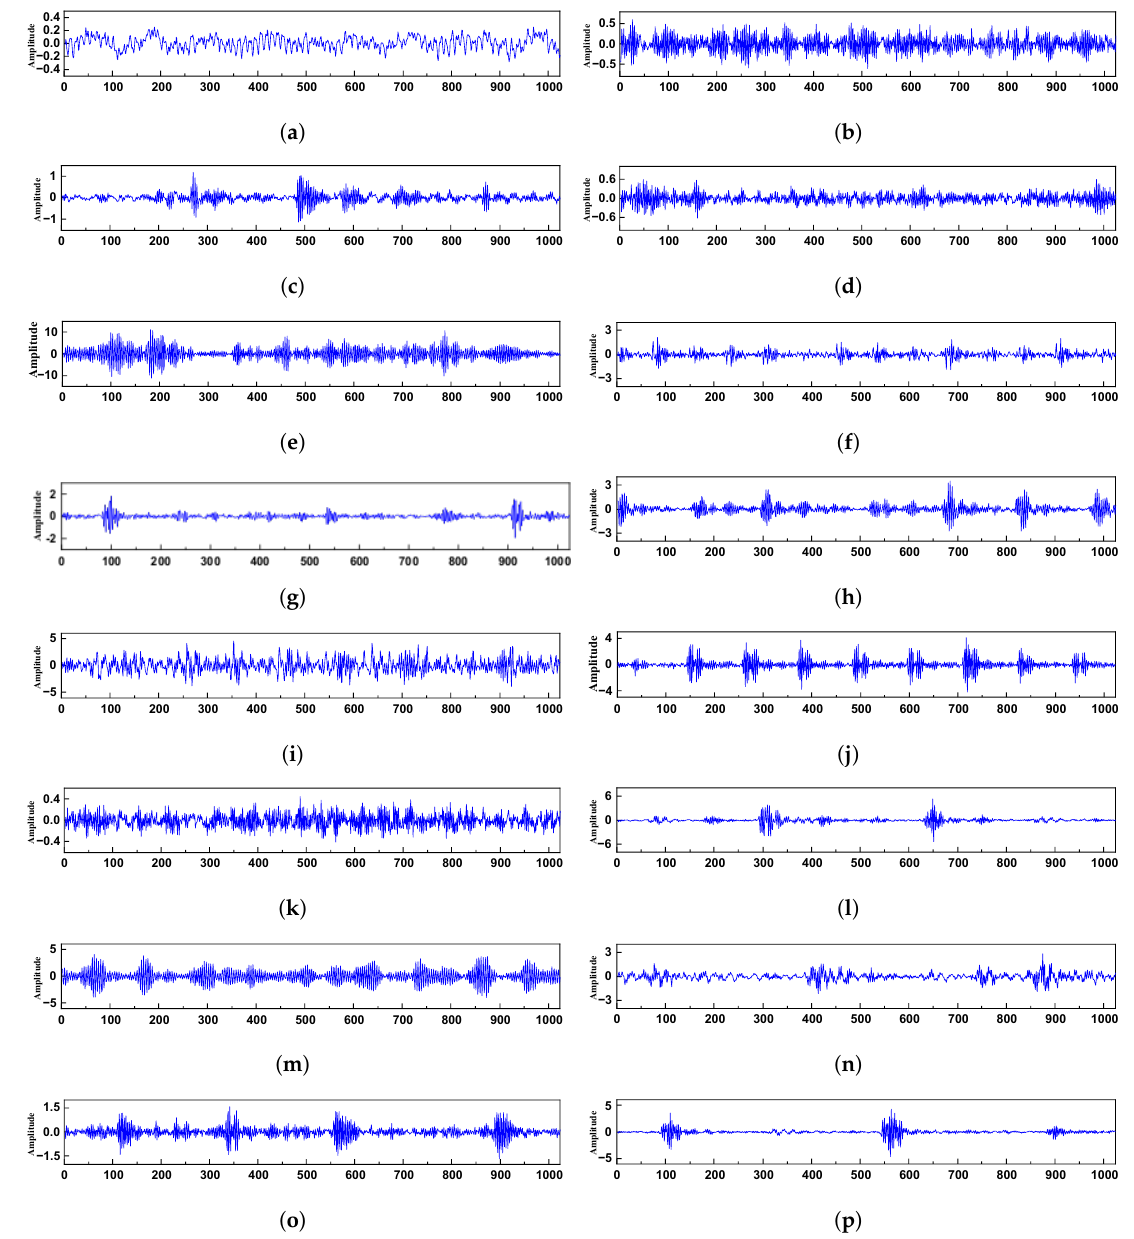
Figure 6. Raw waveforms of the bearing